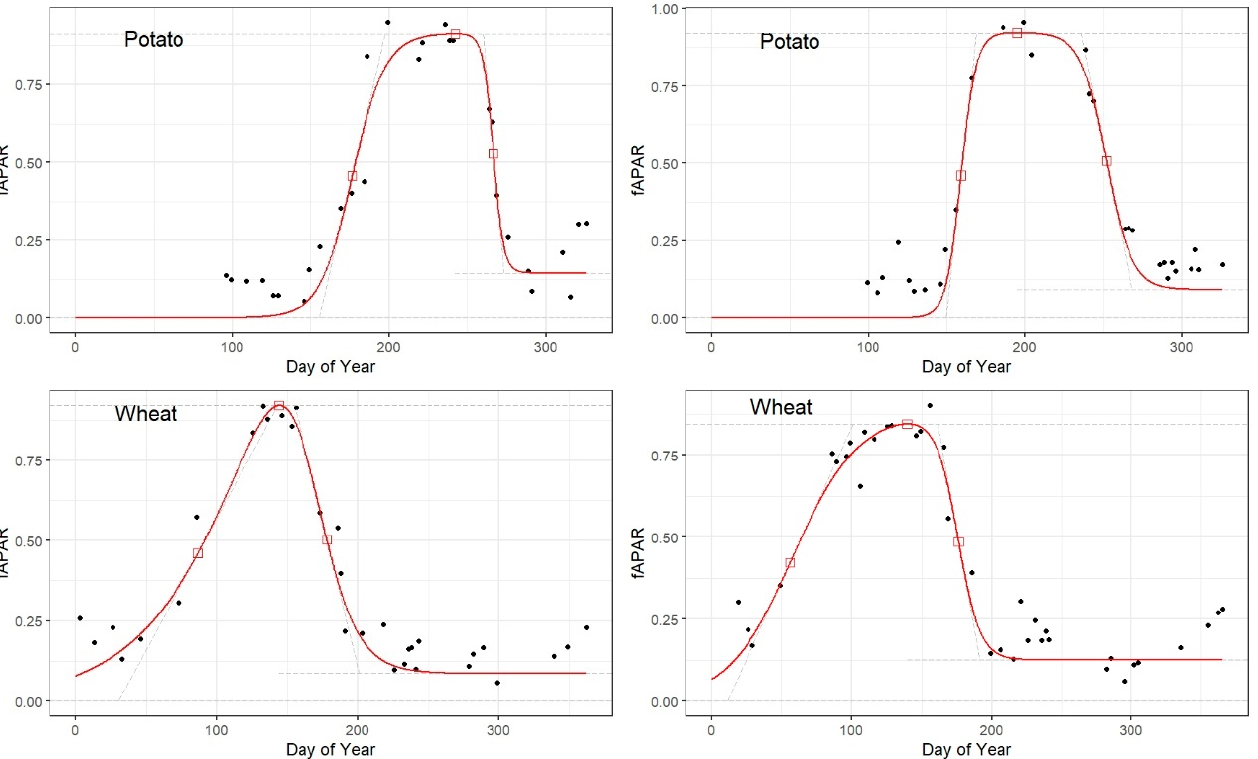
Figure 13. Examples of model fit of fAPAR for two maize, potato, and wheat fields during the 2017 season. The red squares depict the inflection points.